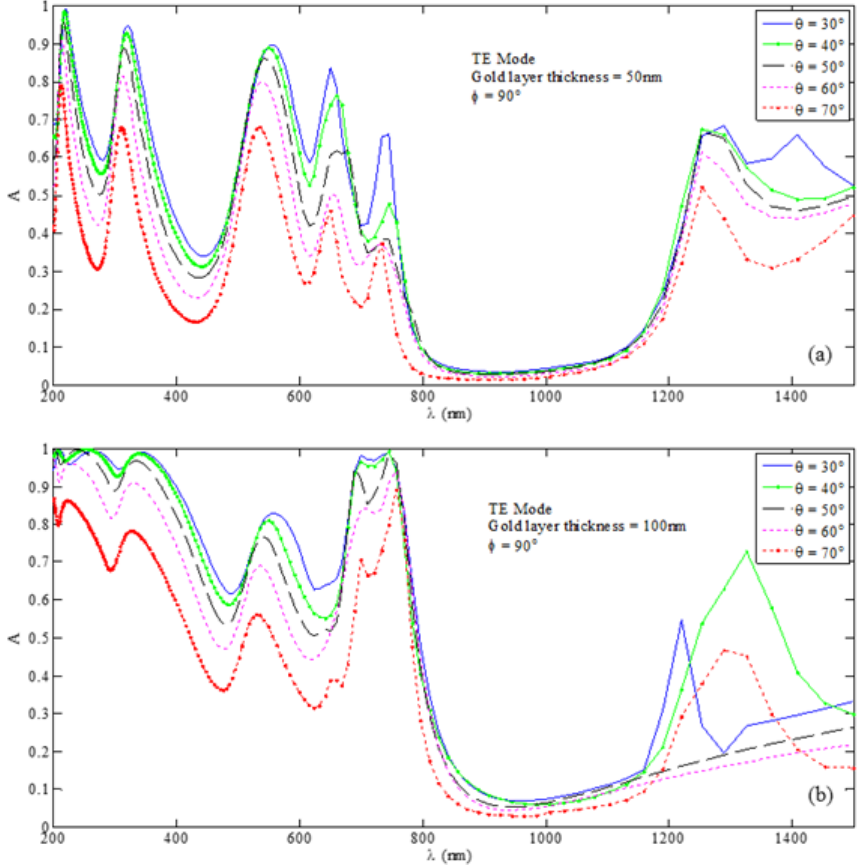
Figure 5. Absorption spectra for the U-shaped MPA nanostructure under the TE wave excitation with ϕ = 90° incidence and corresponding to the cases of ( a ) 𝑑 = 50 nm and ( b ) 𝑑 = 100 nm with 𝑡 = 100 nm.